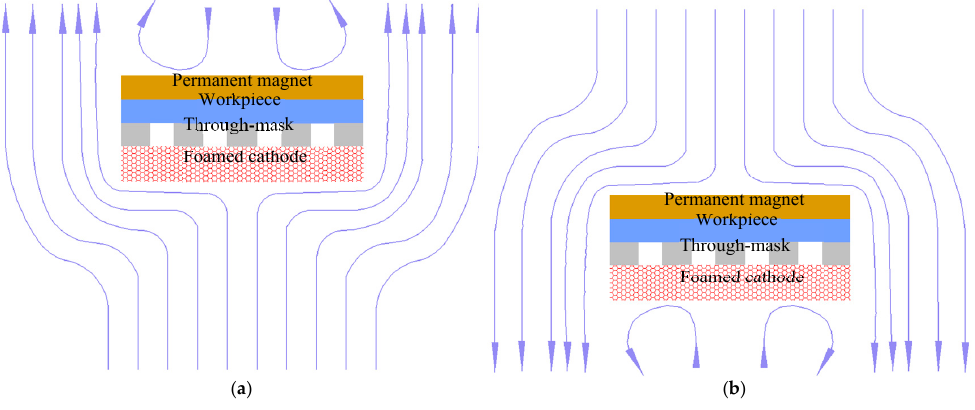
Figure 12. Schematic diagram of the fluid flow driven by the machining assembly moving in a linearly reciprocating way: ( a ) moving downwards; ( b ) moving upward.